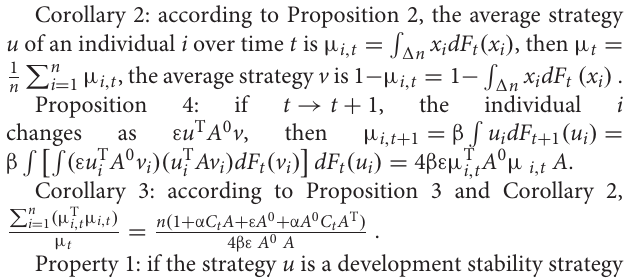
right decision timely, and the number of people infected by COVID-19 in